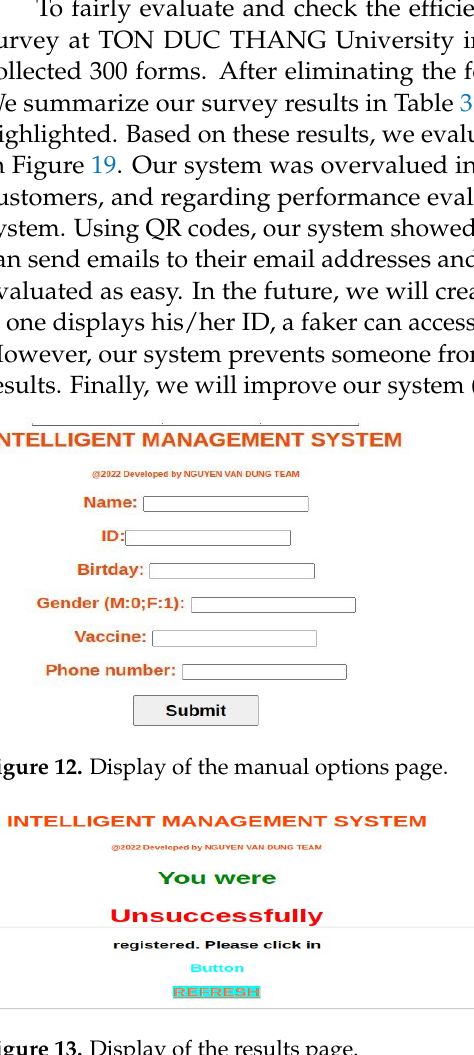
Figure 13. Display of the results